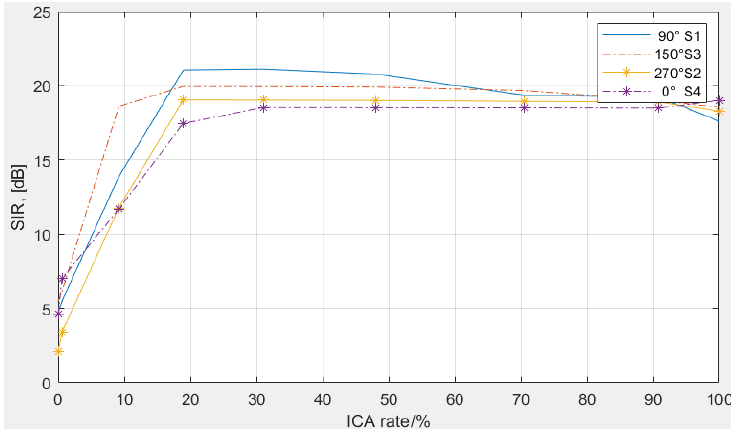
Figure 12. SIR improvement with modified separation under four sources in Room A.